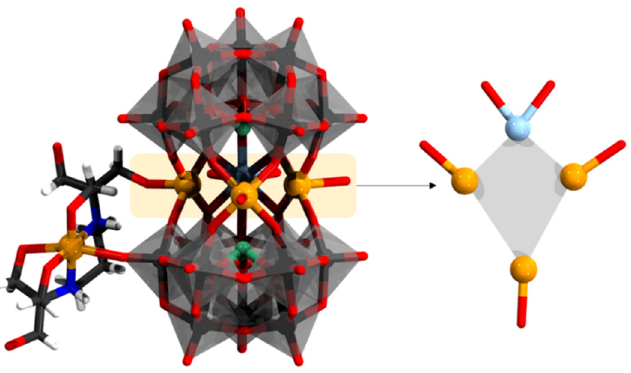
Figure 14. [Cu(H 2 btp)Ho 0.5 Na 1.5 Cu 3 (H 2 O) 5 ( α -AsW 9 O 33 ) 2 ] 11 − and its heterometallic core. Color code: As = green, Cu = orange, N = blue, H = white, C = dark gray, Ho/Na = light blue, {WO 6 } = gray octahedra, W = black, and O = red. H atoms on aqua ligands are omitted.